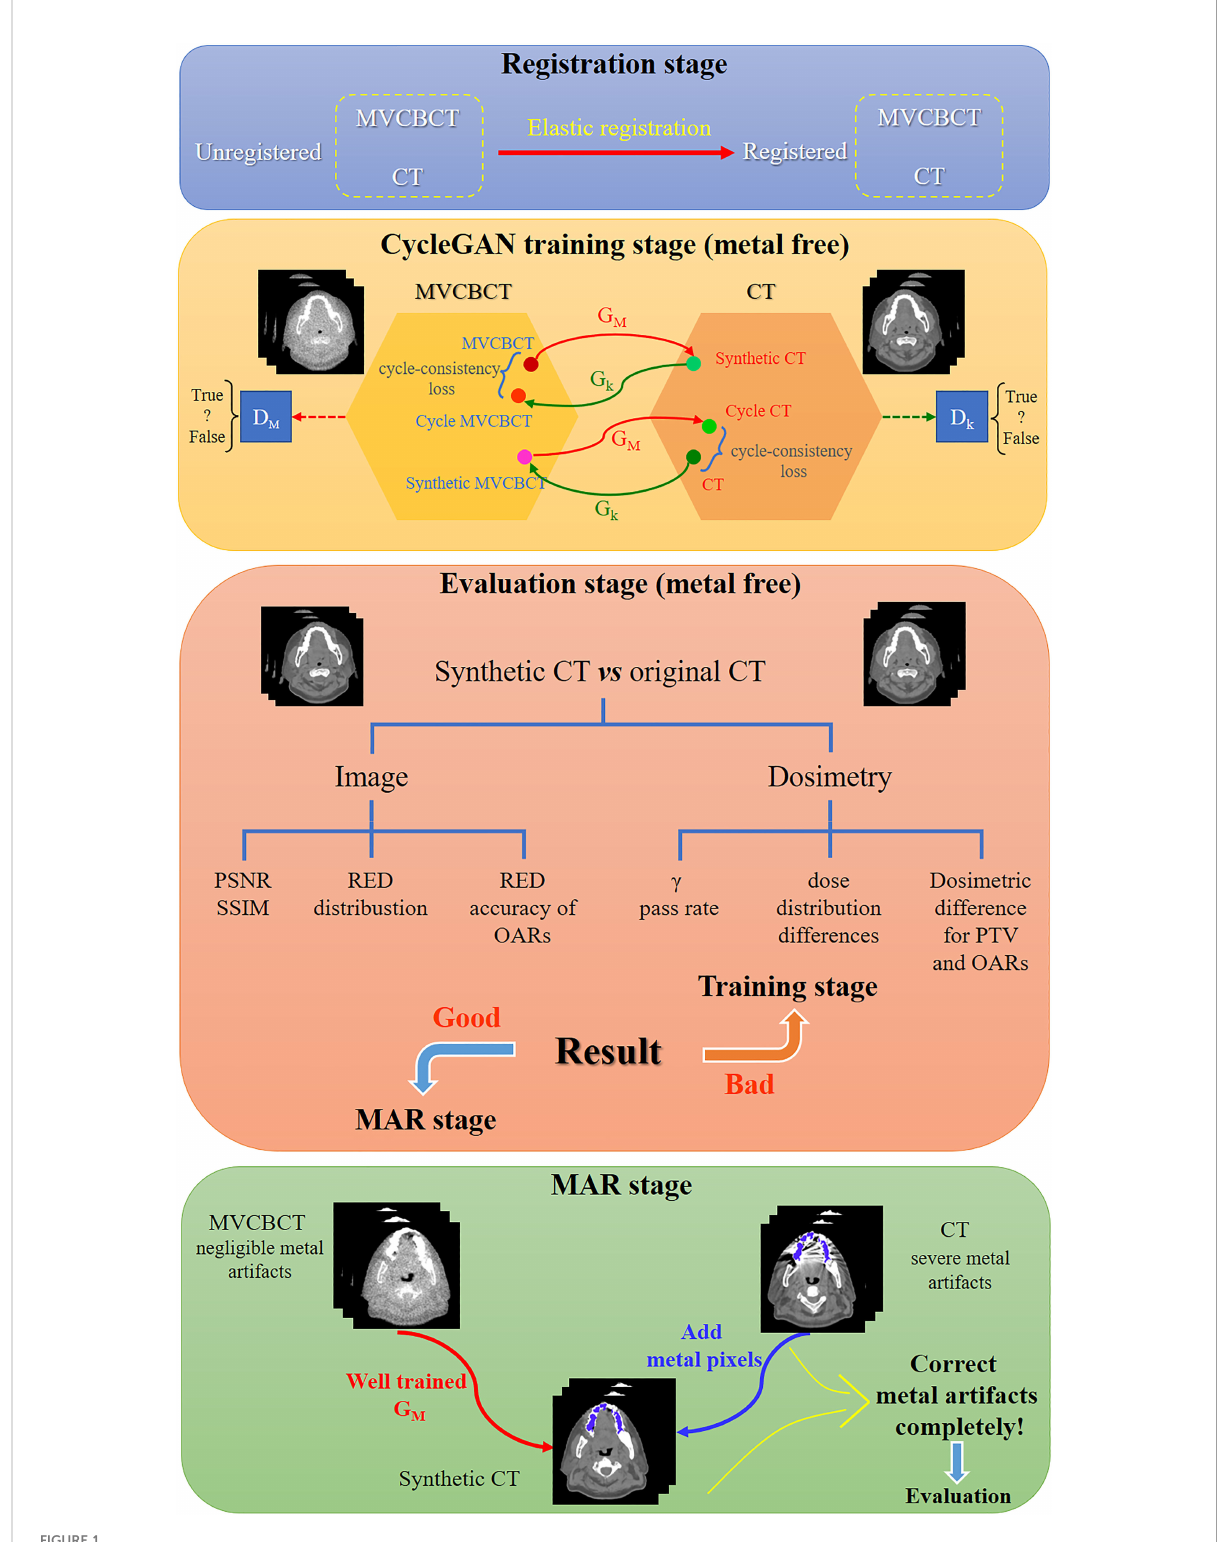
FIGURE 1 Schematic diagram of metal artifact correction based on MVCBCT and CycleGAN. The process of this research was divided into the registration stage, CycleGAN training stage, evaluation stage and MAR